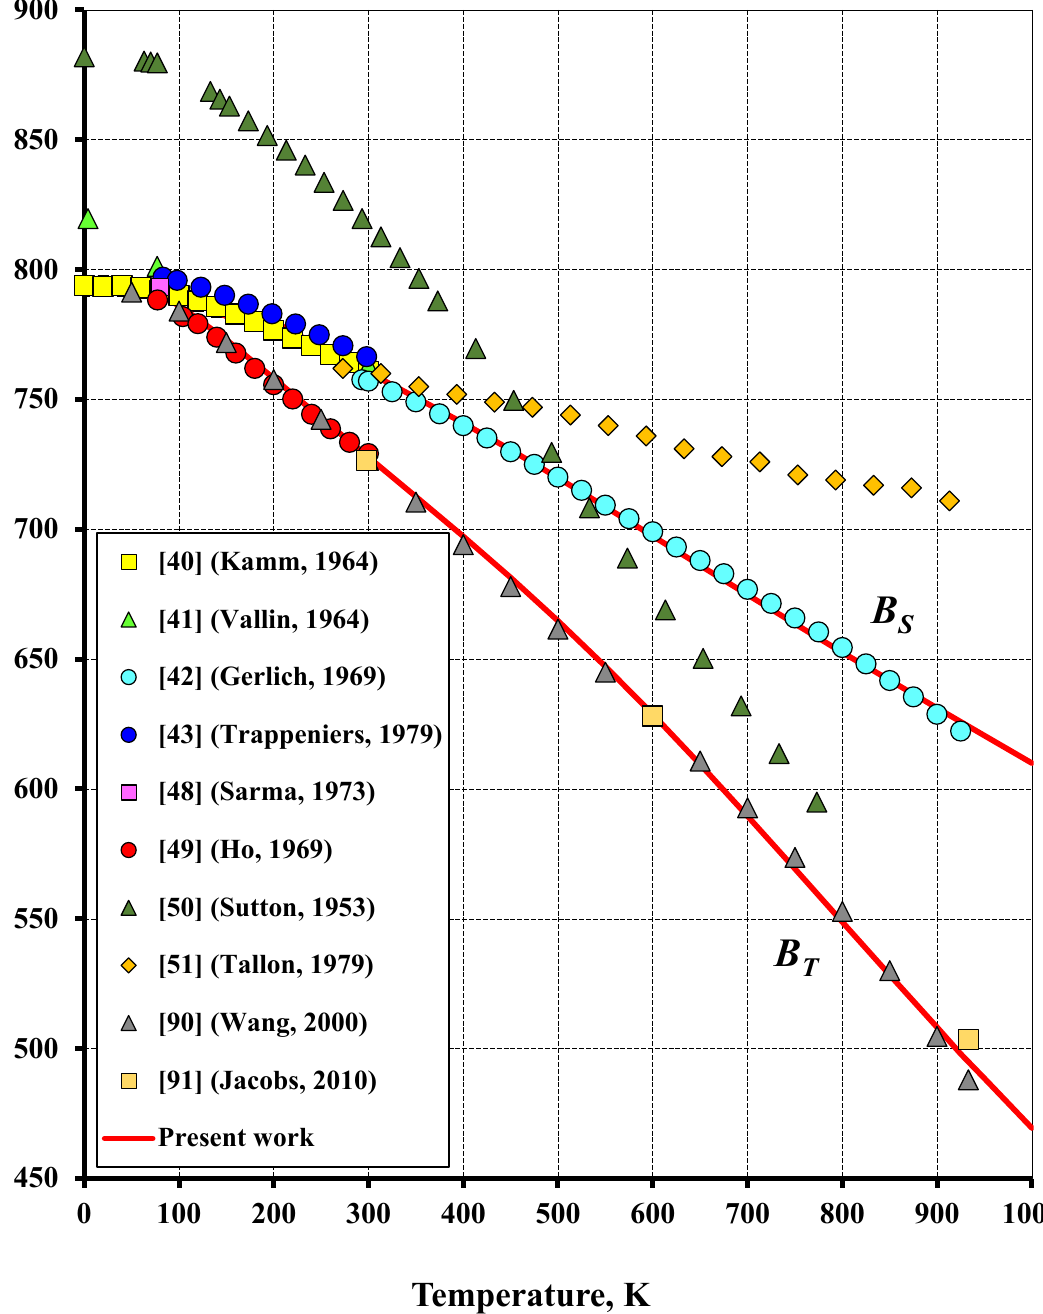
Figure 4. The adiabatic ( B S ) and isothermal ( B T ) bulk moduli of aluminum plotted against tempera- ture.